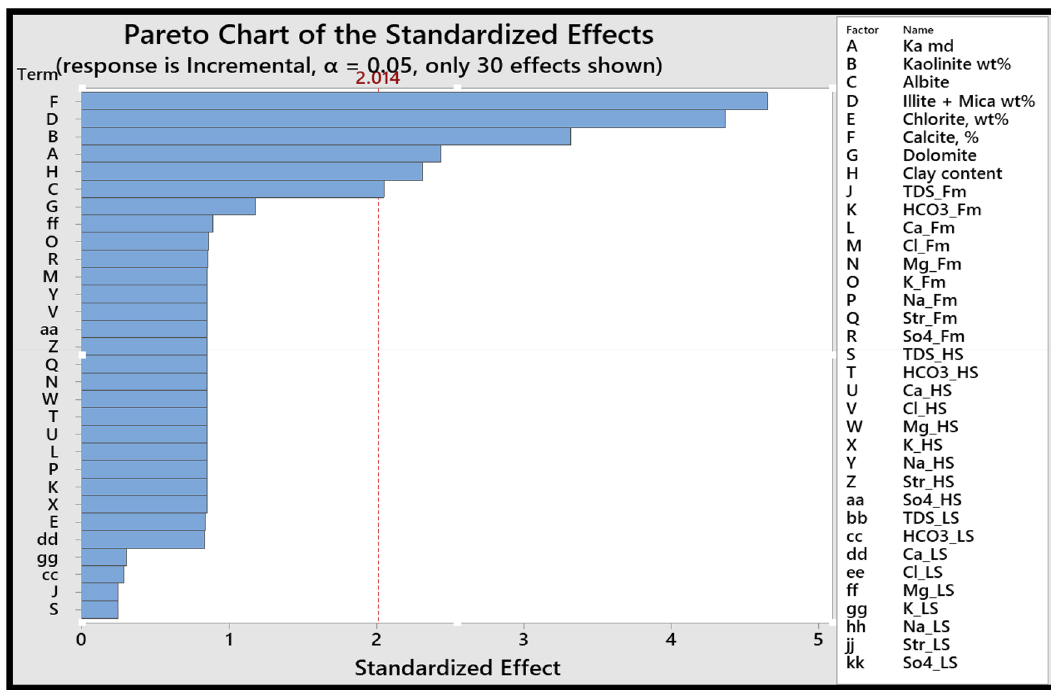
Fig. 11 Pareto chart using the complete dataset of the tertiary